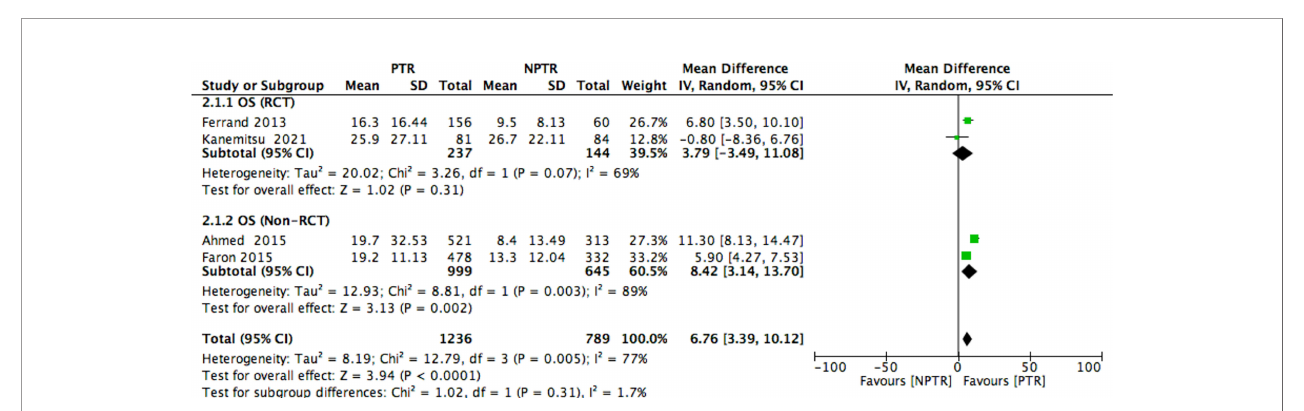
FIGURE 7 | Subgroup analysis of OS Forest